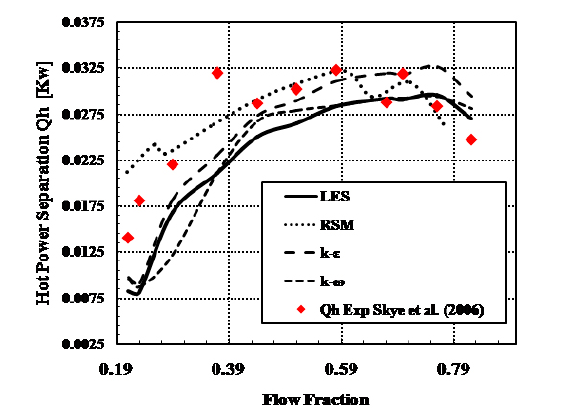
Fig. 17. Variation of the hot power separation for different types of operating gases as a function of the cold flow fraction (compared with experimental results)